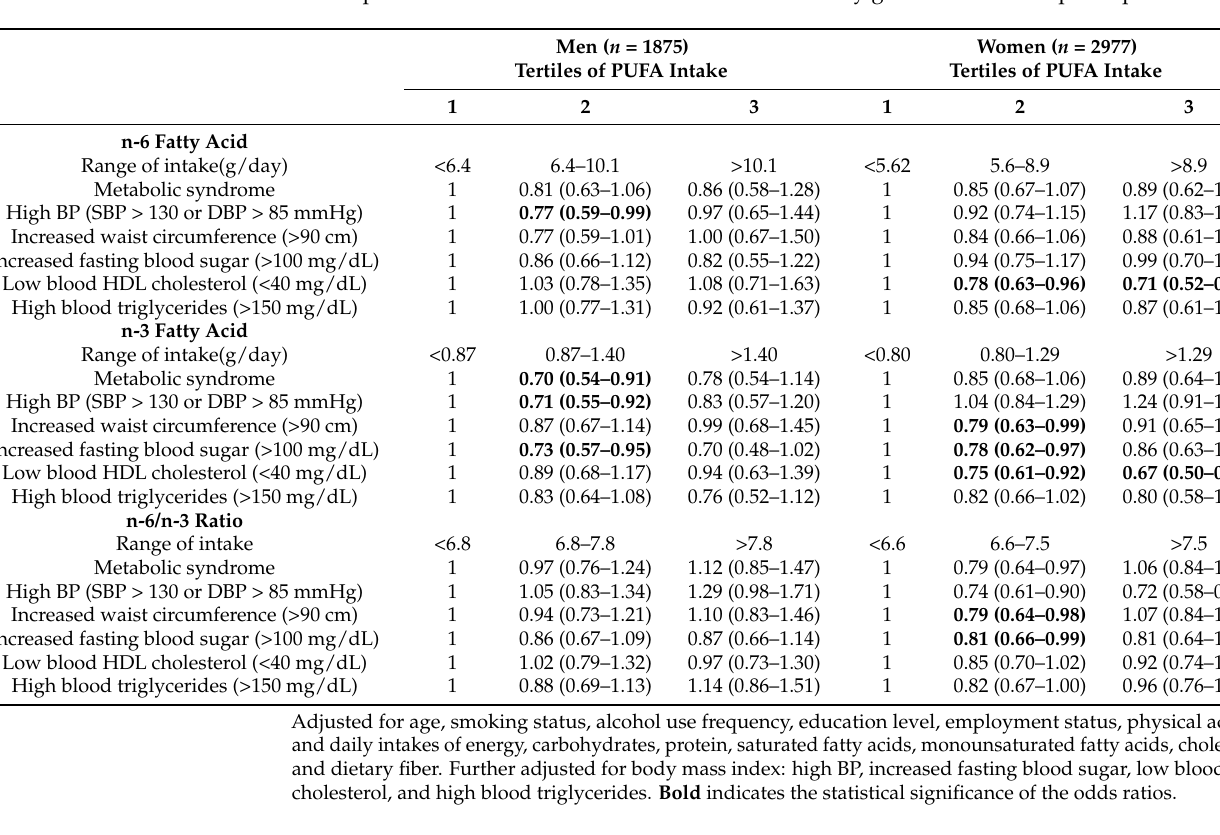
Table 2. Multivariate-adjusted odds ratios and 95% confidence intervals for metabolic syndrome and its components across tertiles of n-3 and n-6 FA intakes by gender for Korean participants.